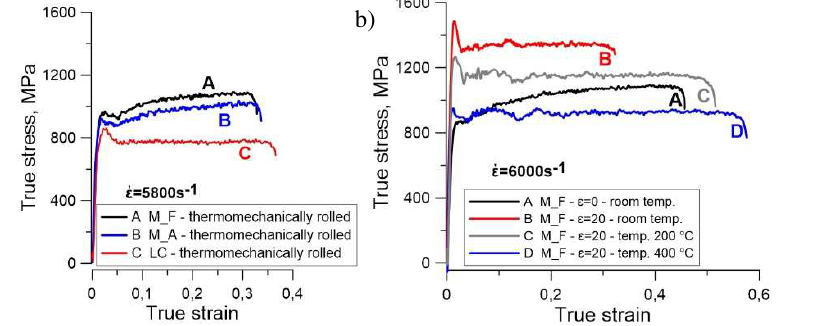
Fig. 3. Comparison of the stress-strain curves obtained in the dynamic compression tests of microalloyed austenite (M_A), microalloyed ferrite (M_F) and low carbon steel (LC) in form of wire rods-a). Stress-strain curves of M_F produced at strain rate of 6000s -1 , as function of the test temperatures of samples after MaxStrain